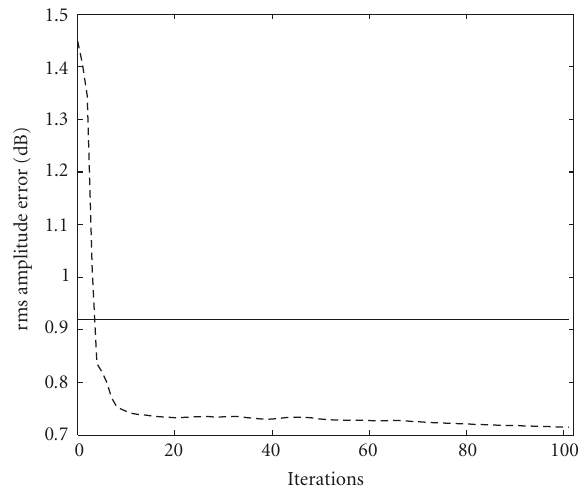
Figure 26: Resultant array amplitude feed-point calibration accu- ) for a single N = 100 array, plotted versus the number of racy ( σ a A calibration iterations.